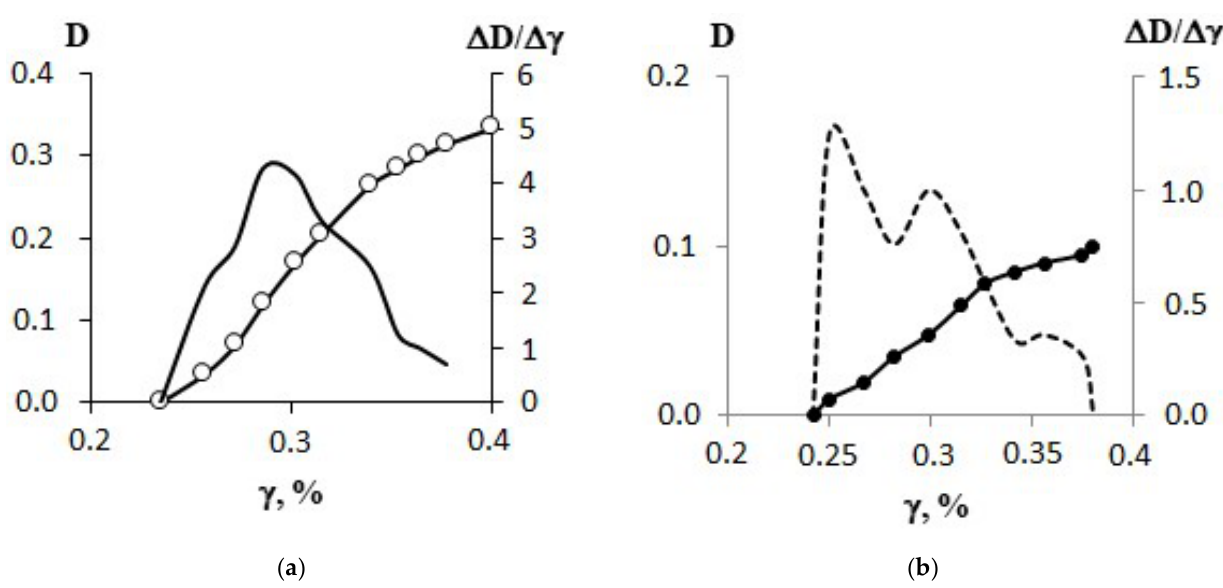
Figure 7. Molecular weight distribution: ( a ) PPSU-17; ( b ) PPSU-3/n/f.